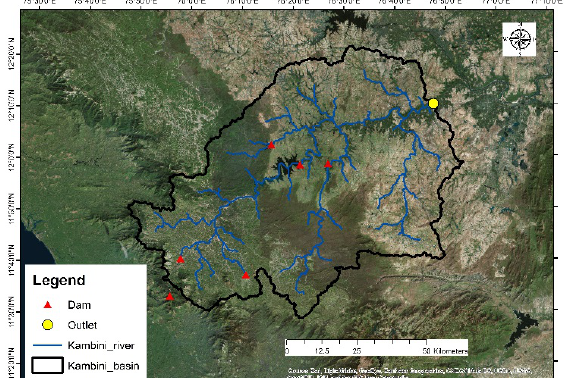
Figure 14a: Kambini River basin and its dam locations